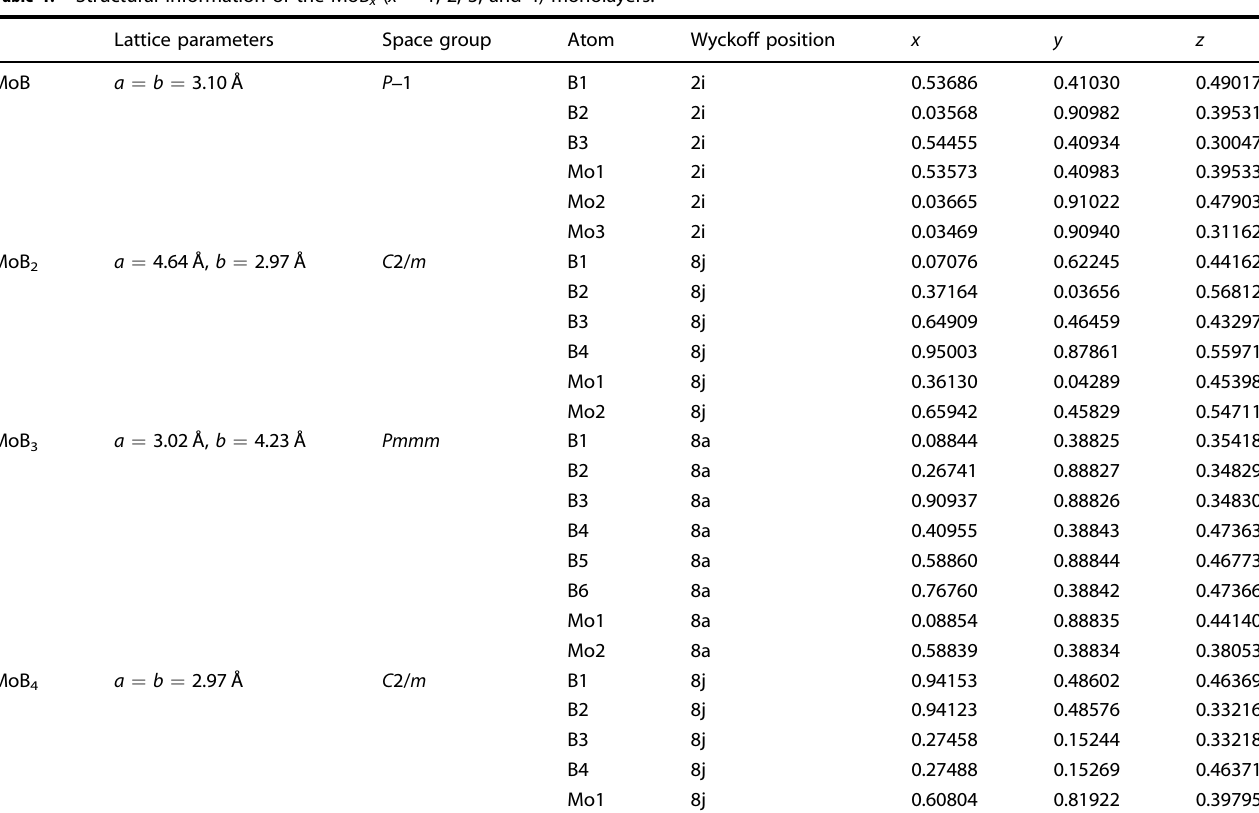
Table 1. Structural information of the MoB x ( x = 1, 2, 3, and 4) monolayers. Lattice